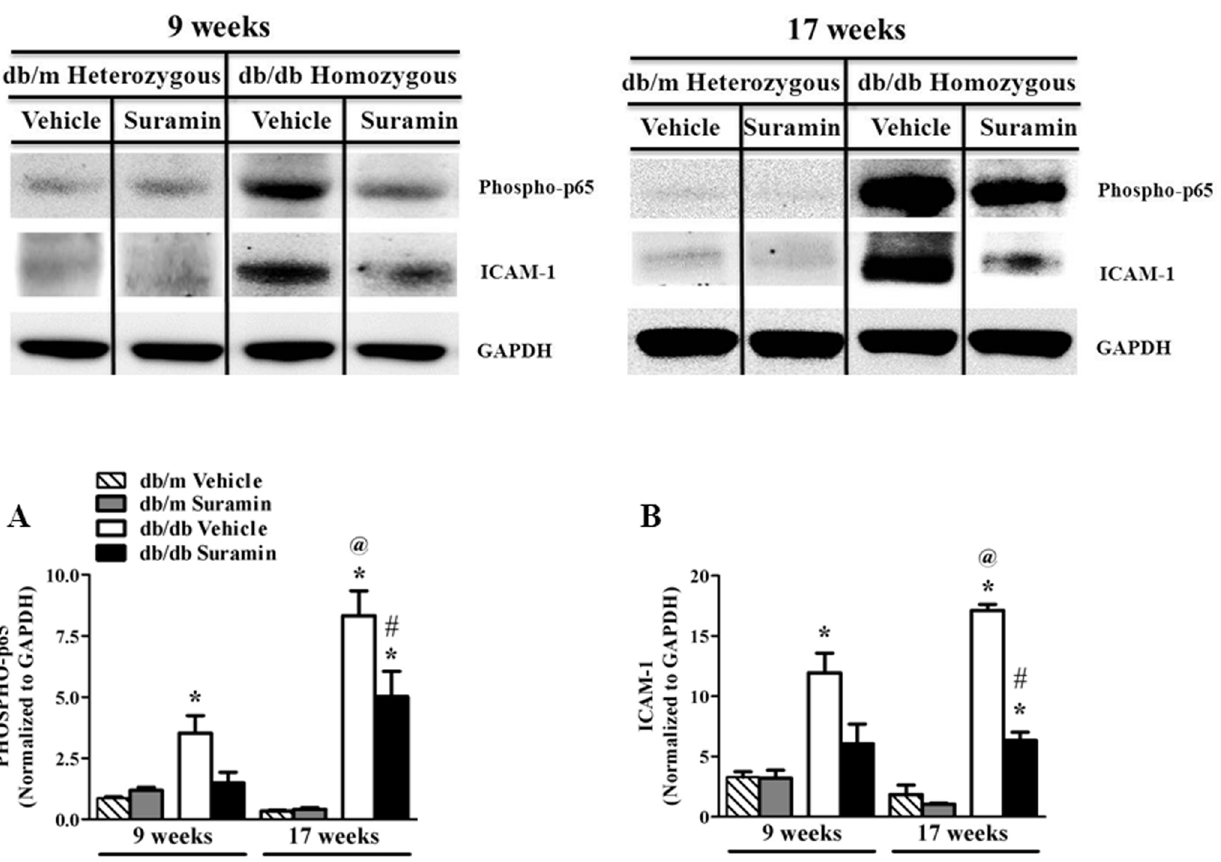
Figure 2. Effect of delayed administration of suramin on renal inflammation in 9/17 week db/db mice. Mice were treated as described in Figure 1. Representative Western blots showing inflammatory markers: phospho-p65 and ICAM-1 in kidneys of 9/17 week db/db mice 6 suramin intervention. ( A ) Densitometric analysis of renal phospho-p65; and ( B ) renal ICAM-1. Data were normalized by GAPDH which served as internal control. Data are expressed as mean 6 SE (n=4). * Significantly different from respective non-diabetic db/m mice ( p # 0.05). # Significantly different from vehicle-treated diabetic db/db mice ( p # 0.05). @ Significantly different from vehicle-treated 9 week diabetic db/db mice ( p # 0.05).